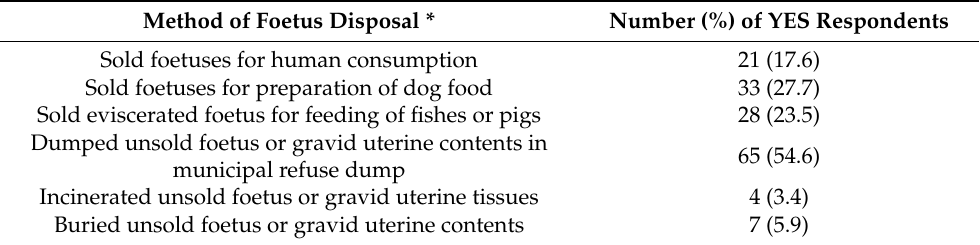
Table 6. Method of disposal of eviscerated foetuses among abattoir workers ( n = 119) surveyed in South-East